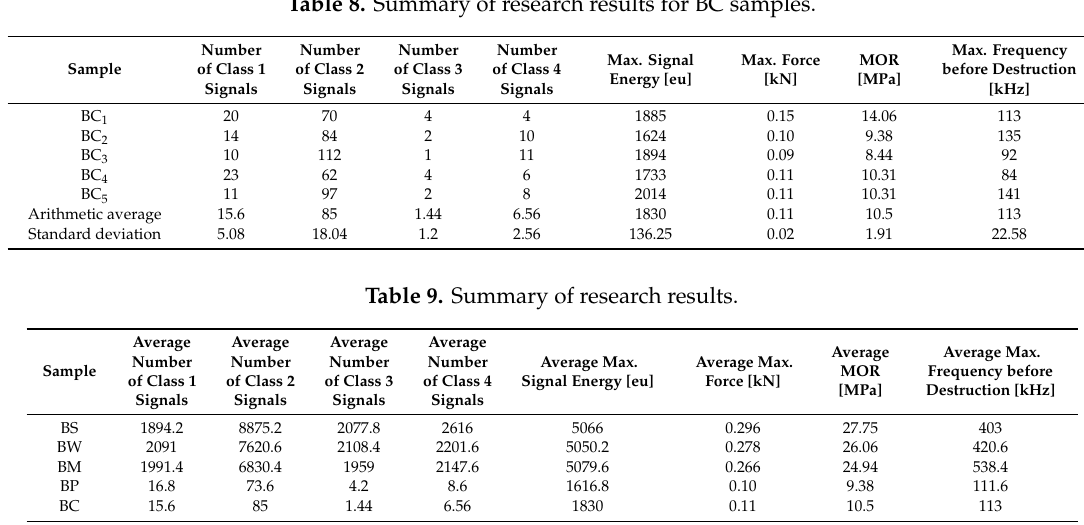
Table 8. Summary of research results for BC samples.